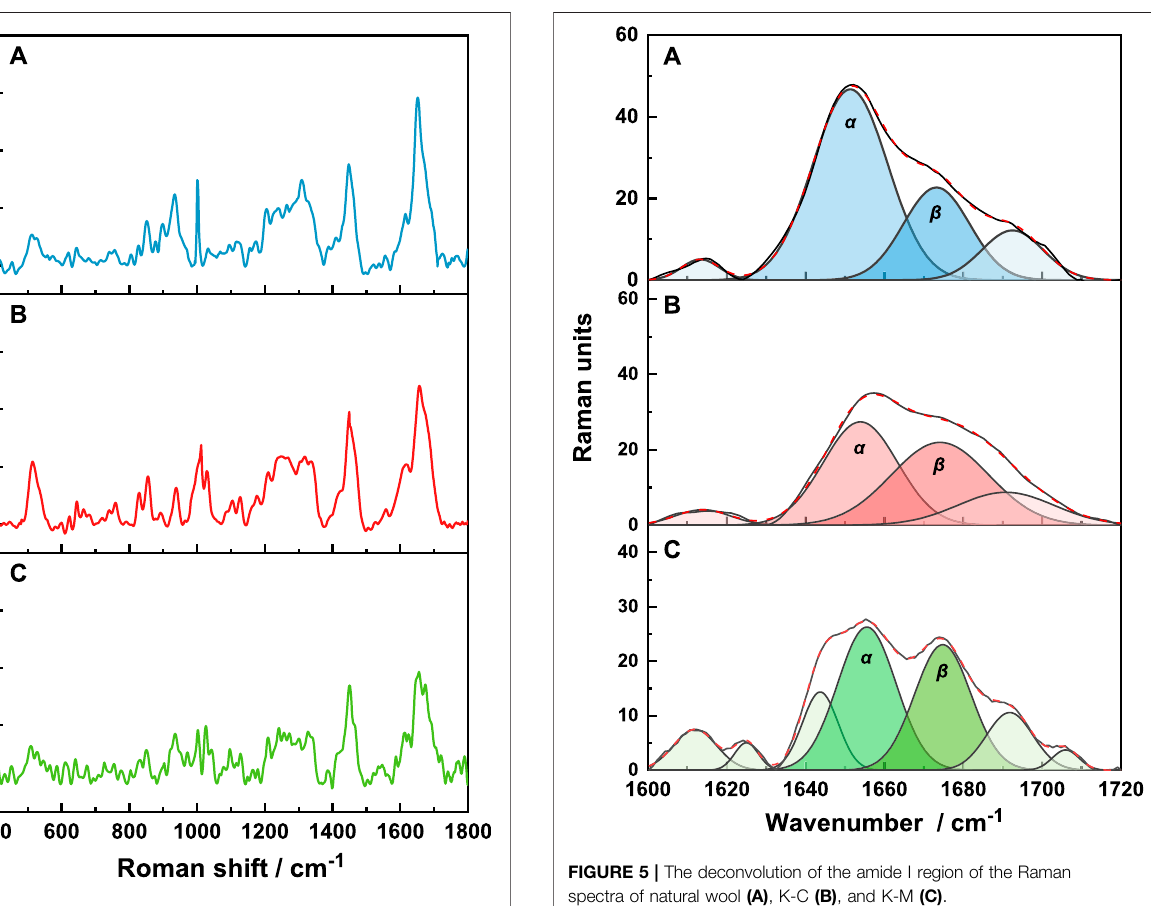
FIGURE 4 | Raman spectra of natural wool (A) , K-C (B) , and K-M (C) .